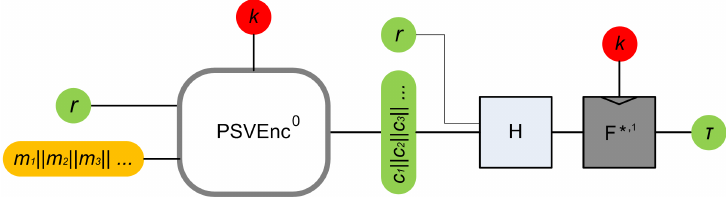
Figure 3: EDT leakage-resilient authenticated